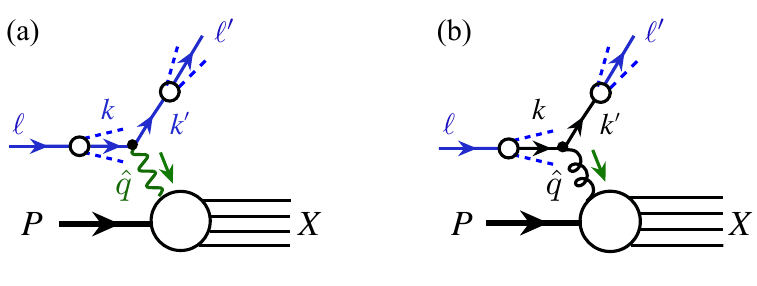
Figure 6 . Sketch of sample scattering amplitudes for inclusive DIS with (a) one-photon exchange, and (b) one-gluon